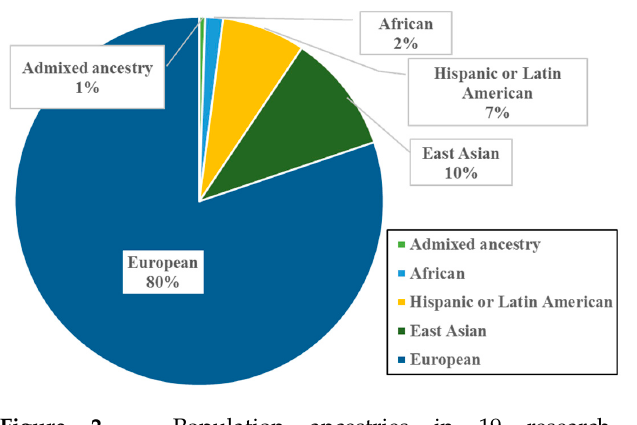
Figure 2. Population ancestries in 19 research studies investigating SNP-face morphology [91,146,154,157–172]. These percentages include both discovery and replication samples.